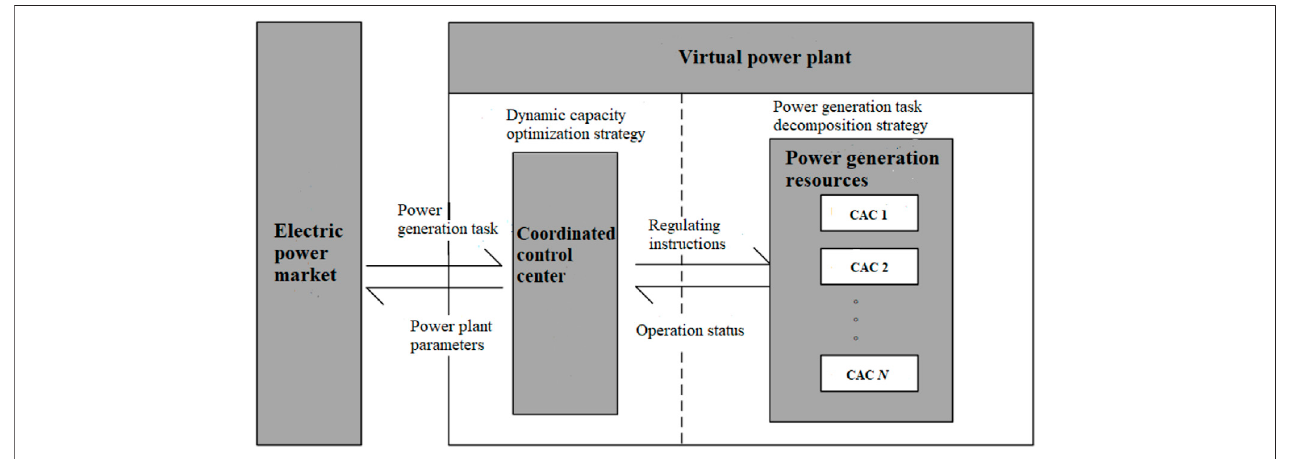
FIGURE 5 | Schematic diagram of VPP